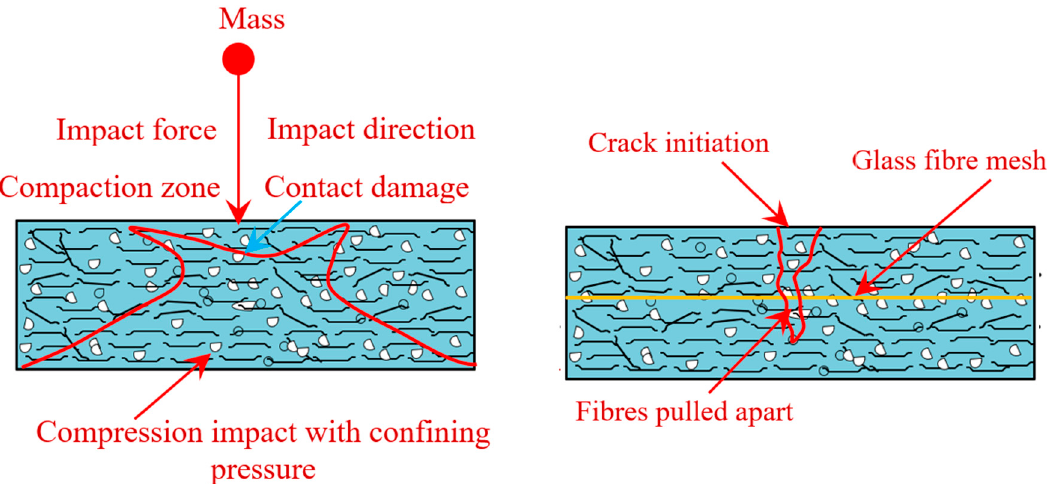
Figure 17. Failure mechanism of PAFC under impact loading.